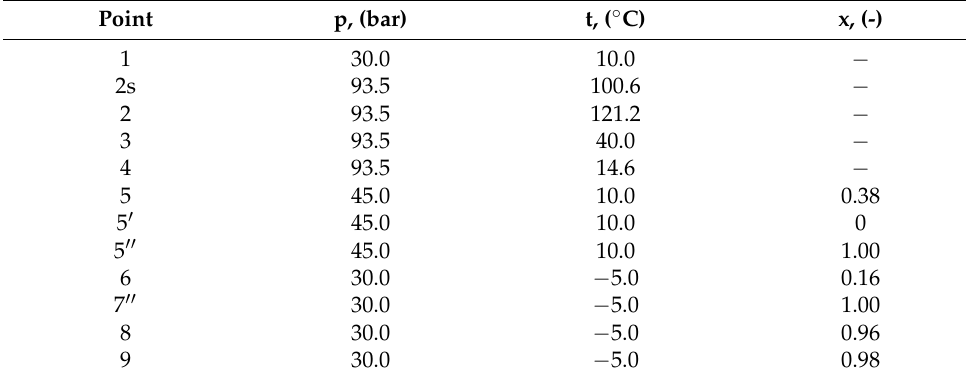
Table 3. Parameters of the supercritical cycle (characteristics